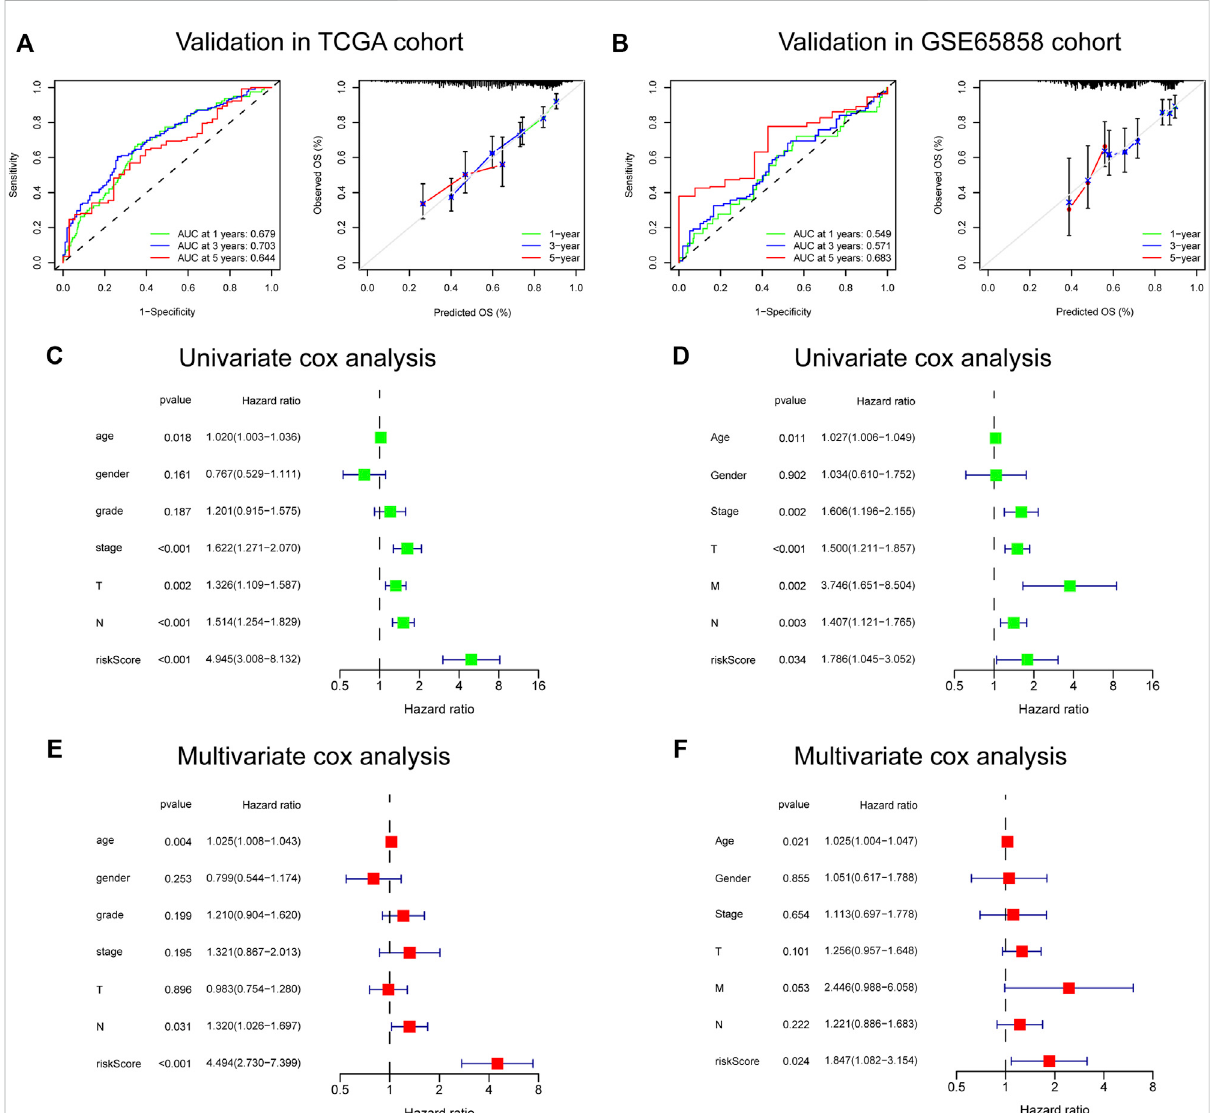
FIGURE 8 Validation of the 8-gene signature in TCGA and GSE65858 cohorts. (A,B) The ROC and calibration curves for determining the accuracy of model. (C – F) Univariate and multivariate analysis of clinical features and risk